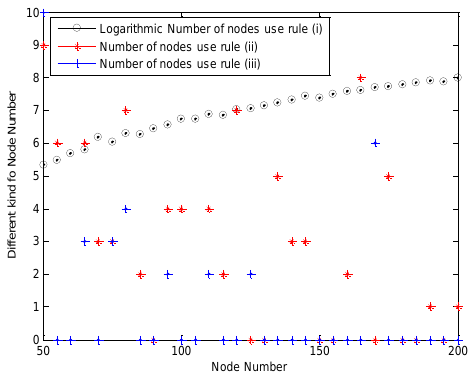
Figure 10. The number of different kind of communication links in different scenario.